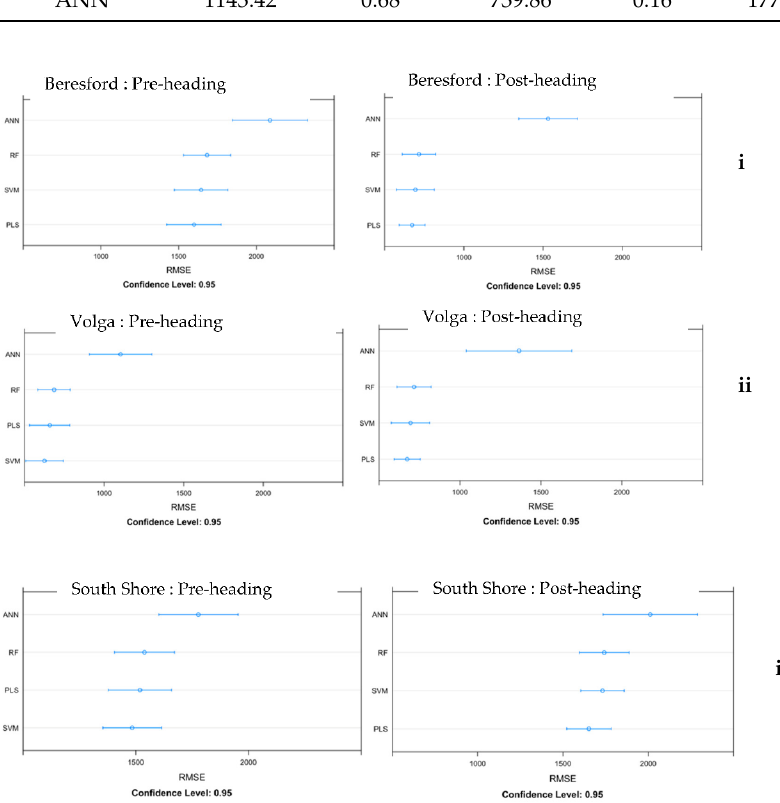
Figure 8. Plots of Predicted Vs Actual biomass yield for 35 oat genotypes grown in Beresford ( A) , Volga ( B ), and South Shore ( C ) for pre-heading ( i ) and post-heading ( ii ) phase. The horizontal axis represents the predicted biomass yield obtained from the model, and the vertical axis represents the biomass measured manually at ground level.